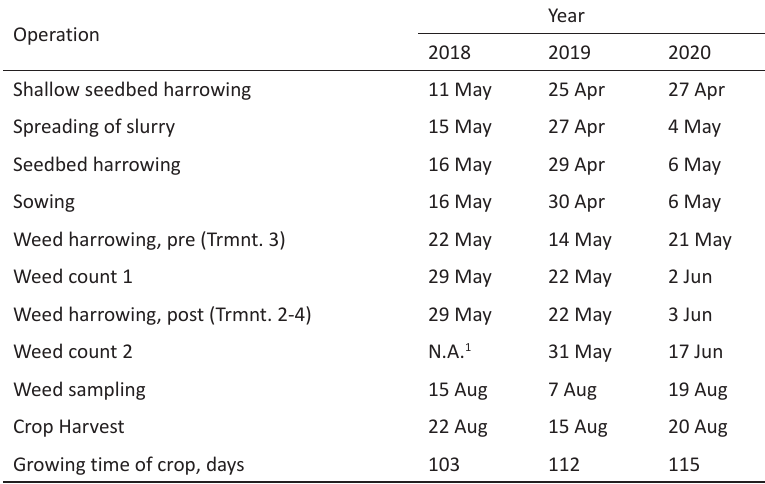
Table 2. Diary of field operations in the experimental field during